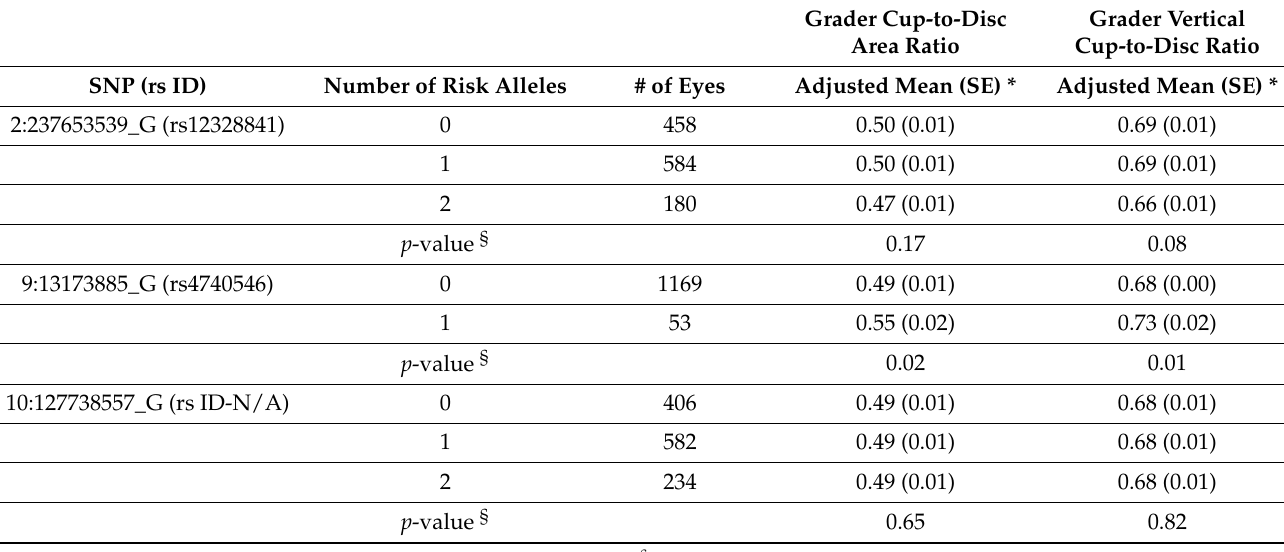
Table 1. Association between SNPs previously associated with clinical VCDR with grader CDR measurements in glaucoma cases (N = 623 patients, 1222